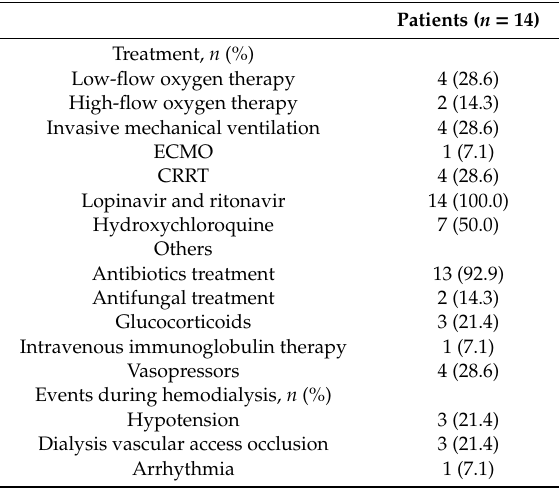
Table 3. Treatment.